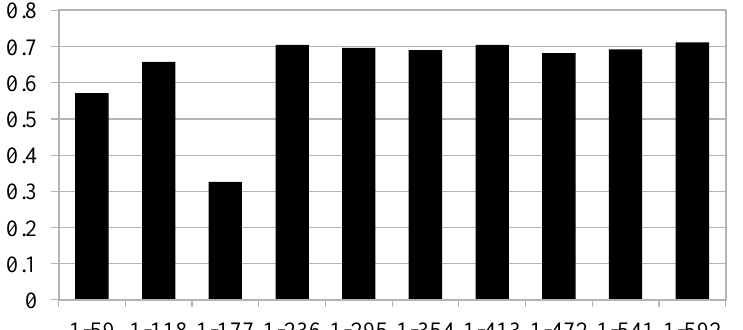
Figure 1. R 2 between PCA and capital city distances for each subset of 59 features